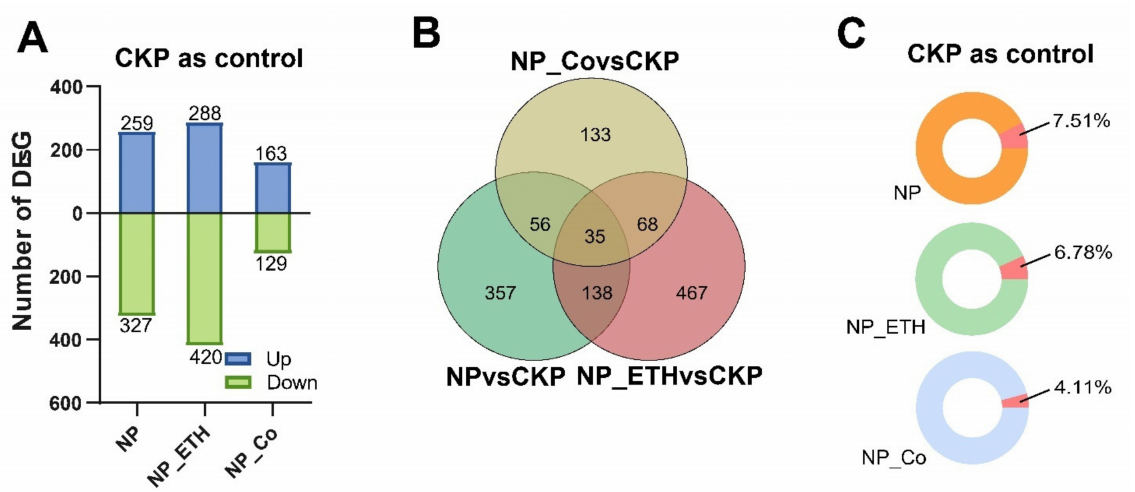
Figure 2. Identification of DEGs in three treatment groups, CKP (normal phosphate (Pi)) as control, NP (Pi starvation), NP_ETH (Pi starvation and ethephon) and NP_Co (Pi starvation and CoCl 2 ) were each experimental group. ( A ) The histogram indicates upregulated and downregulated DEGs, blue indicates up-regulation, green indicates down-regulation, Y -axis indicates the number of DEGs, and X -axis represents the experimental group name. ( B ) Venn diagram of the DEGs among three treatment groups, and the number represents the number of DEGs. ( C ) Donut chart indicates the percentage of TFs in three groups. NP (Pi starvation treatment), NP_ETH (Pi starvation and ethephon treatment), NP_Co (Pi starvation and CoCl 2 treatment).